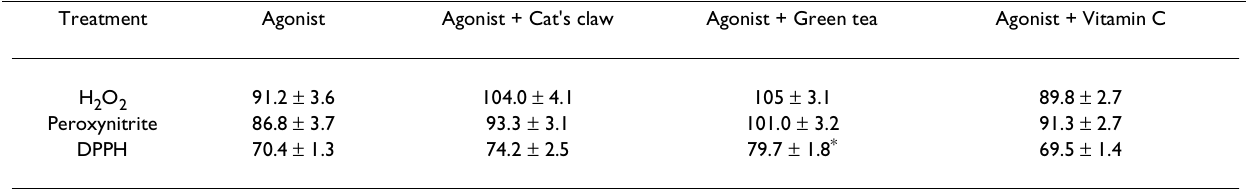
Table 2: Changes in AGS Cell Viability (MTT Assay) in Response to Oxidants and the Effects of Dietary Antioxidants Treatment